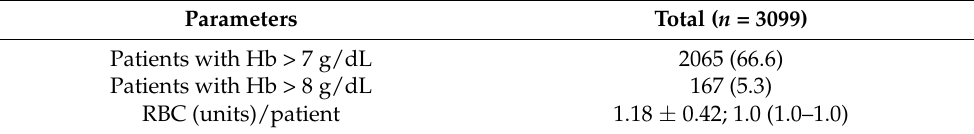
Table 2. Transfused patients without comorbidities, and number of transfused RBC units.